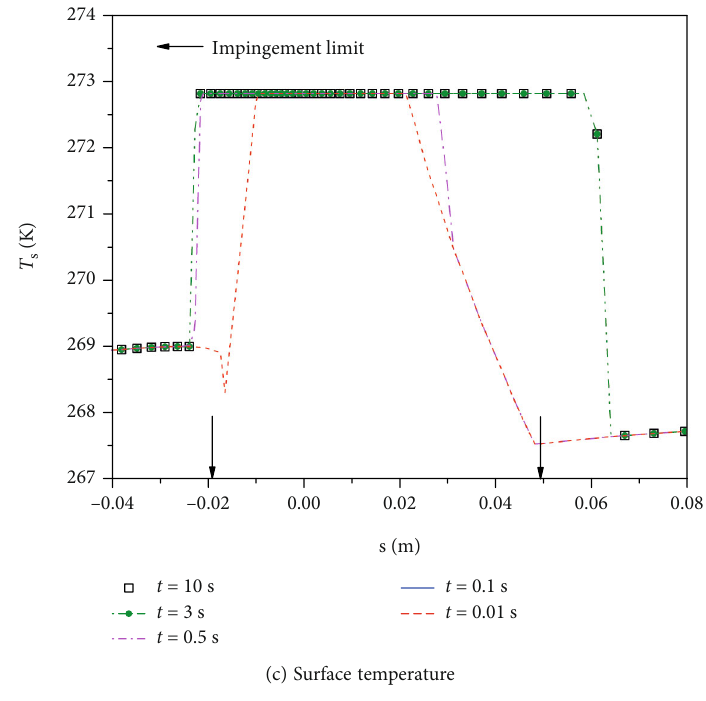
Figure 6: Icing results at di ff erent times for